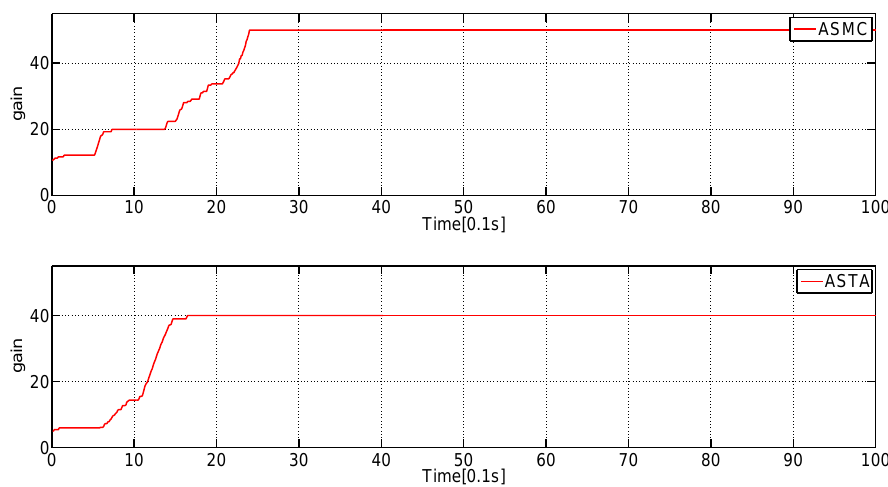
Figure 10. Comparison of the adaptive gains in Case